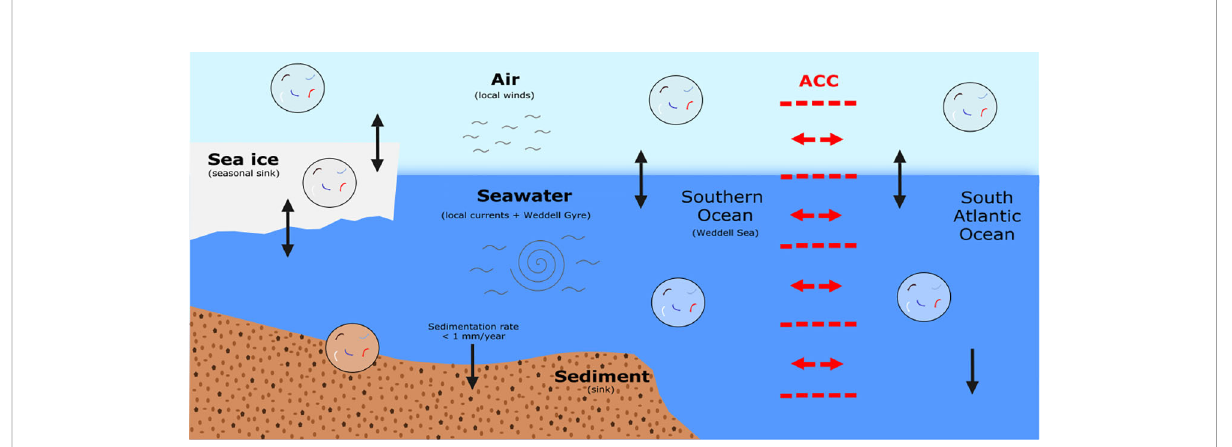
FIGURE 5 An infographic illustrating the multiple transportation processes that impact upon the presence and fate of microplastic fi bre pollution in multiple media including air, seawater, sediment, and sea ice. In red, we show the ACC, and with black arrows the transfer of fi bres between the different media. In grey, we show winds/currents and the cyclonic Weddell Gyre. The sedimentation rate value was taken from Dowdeswell et al.